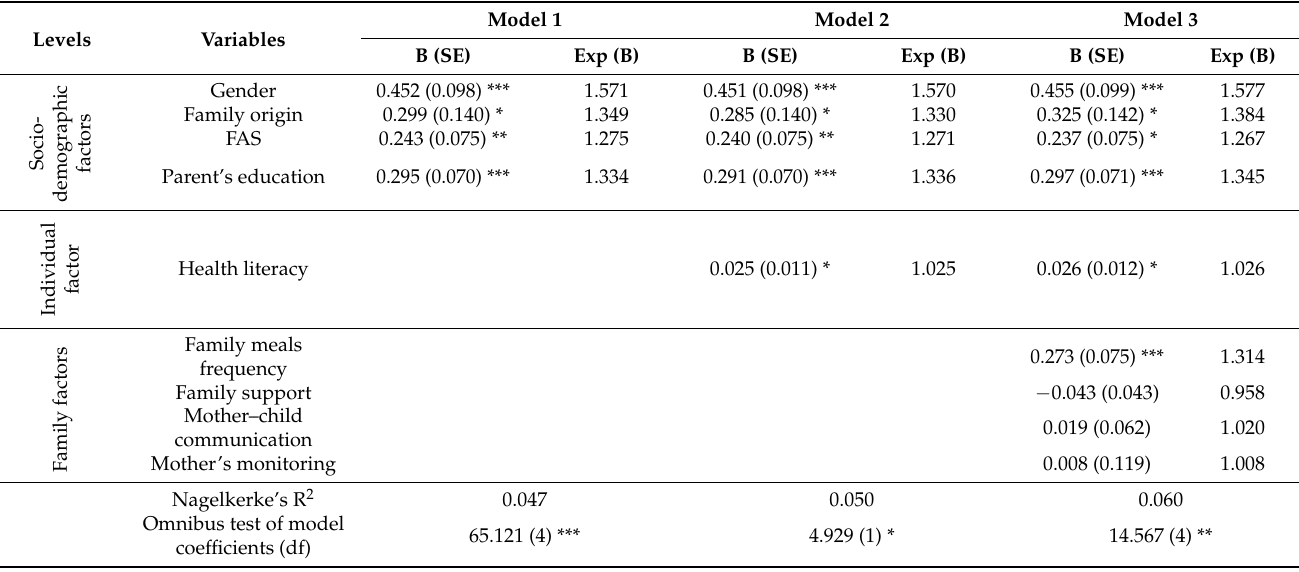
Table 3. Results of multiple binary logistic regression models predicting fruit